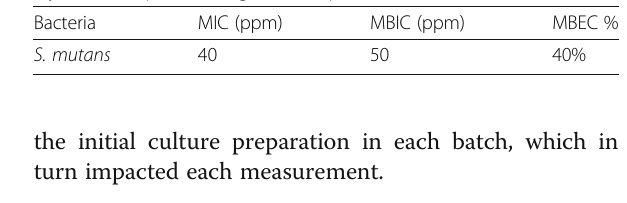
Table 2 Inhibition and Eradication of by a terpenoid